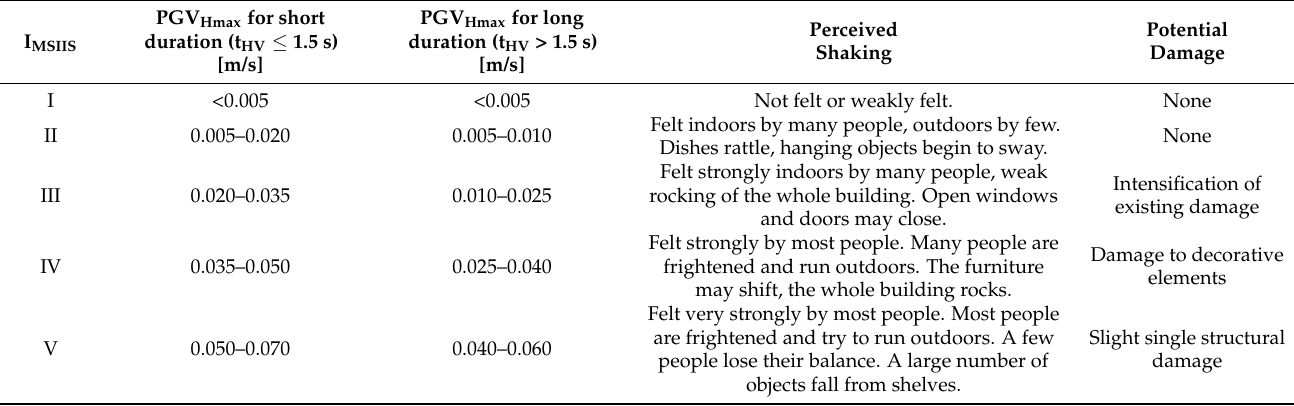
Table 1. Short form of the Mining Seismic Instrumental Intensity Scale [5].